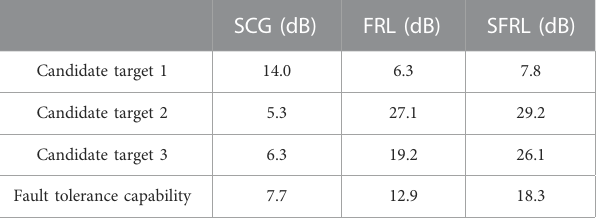
TABLE 2 Processing results of candidate targets with different